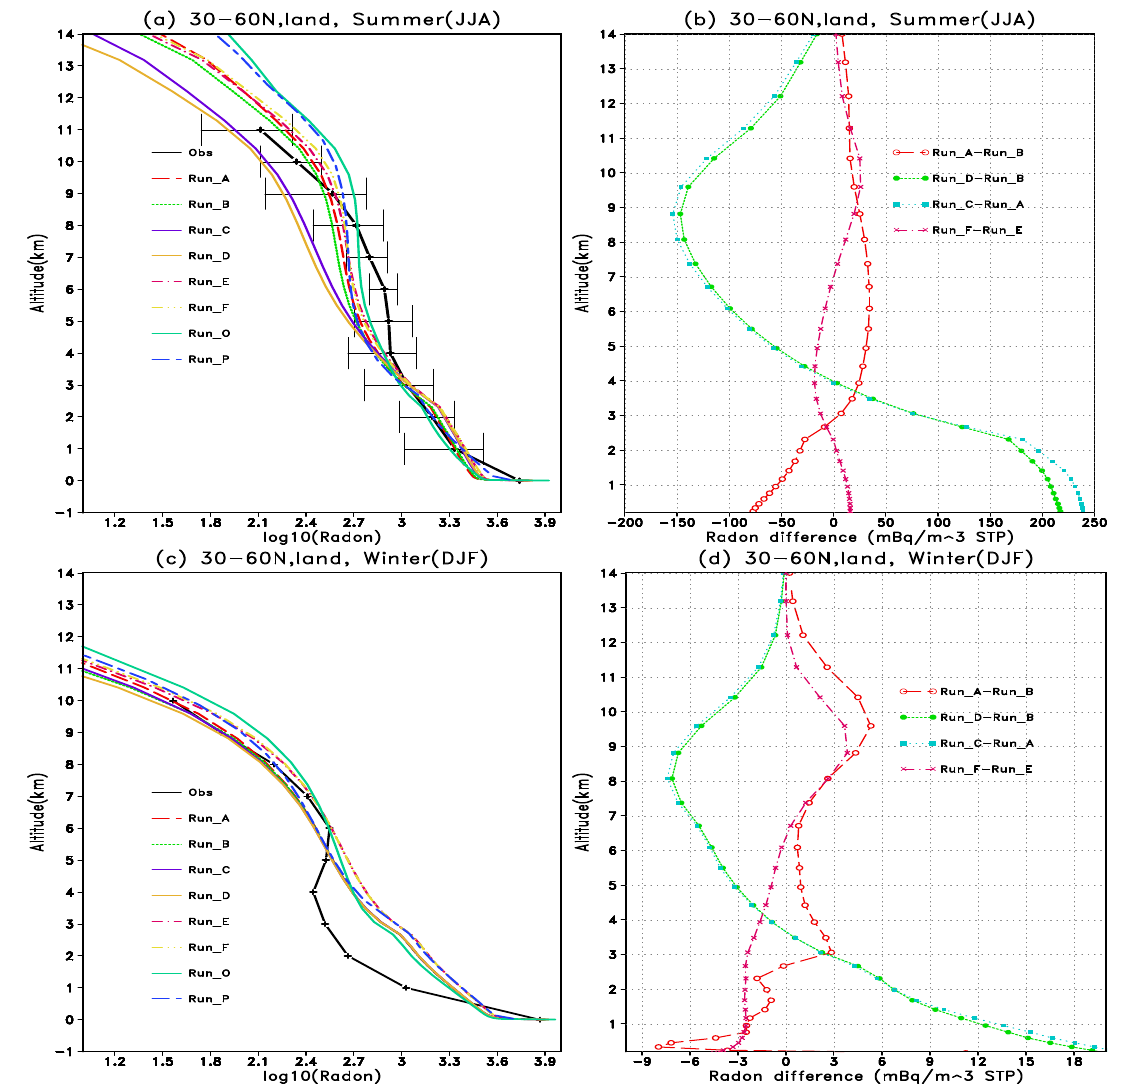
Fig. 13. Comparison of observed radon profiles (mBq/m 3 STP) averaged between 30 ◦ N and 60 ◦ N over land for (a) summer (JJA) and (b) winter (DJF) with model runs “A E40”, “B EI”, “C E40noconv”, “D EInoconv”, “E EInewevap”, “F EInewconv”, “O EIar” and “P det”. Panels (c) and (d) show the differences between runs “A E40”-“B EI”, “D EInoconv”-“B EI”, “C E40noconv”-“A E40”, and “F EInewconv”-“E EInewevap” for summer and winter, respectively.